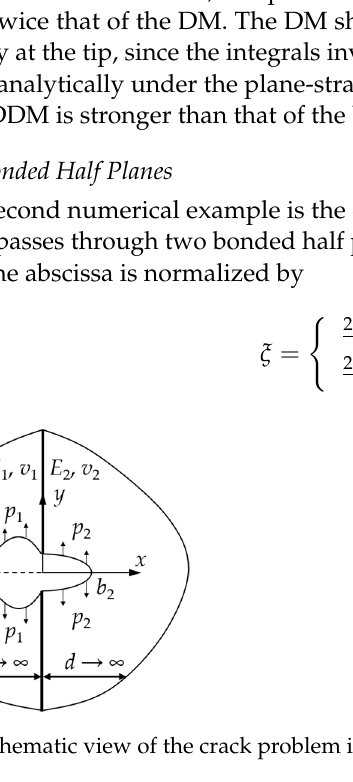
Figure 7. Percentage errors of the DDM and the DM with ( a ) 5 crack elements and ( b ) 100 crack elements.